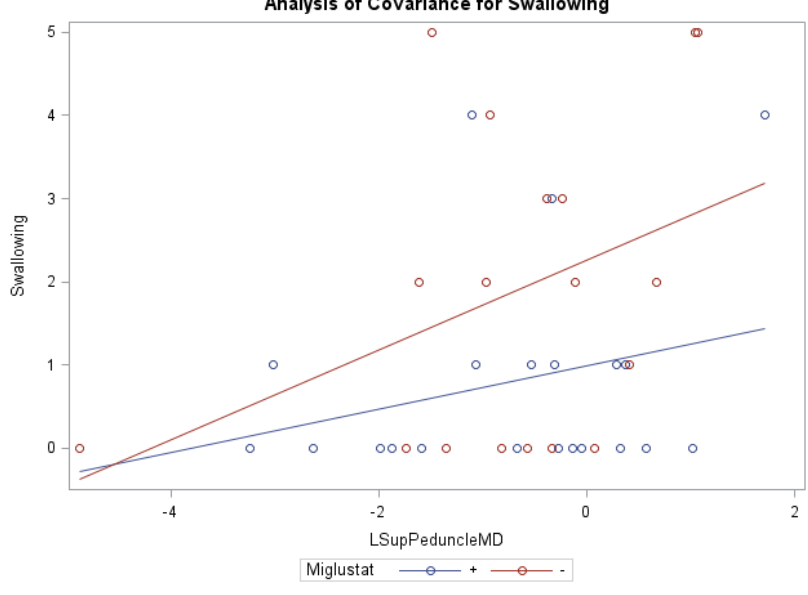
Figure 3. ANCOVA of swallowing, miglustat therapy, and MD of left superior peduncle.